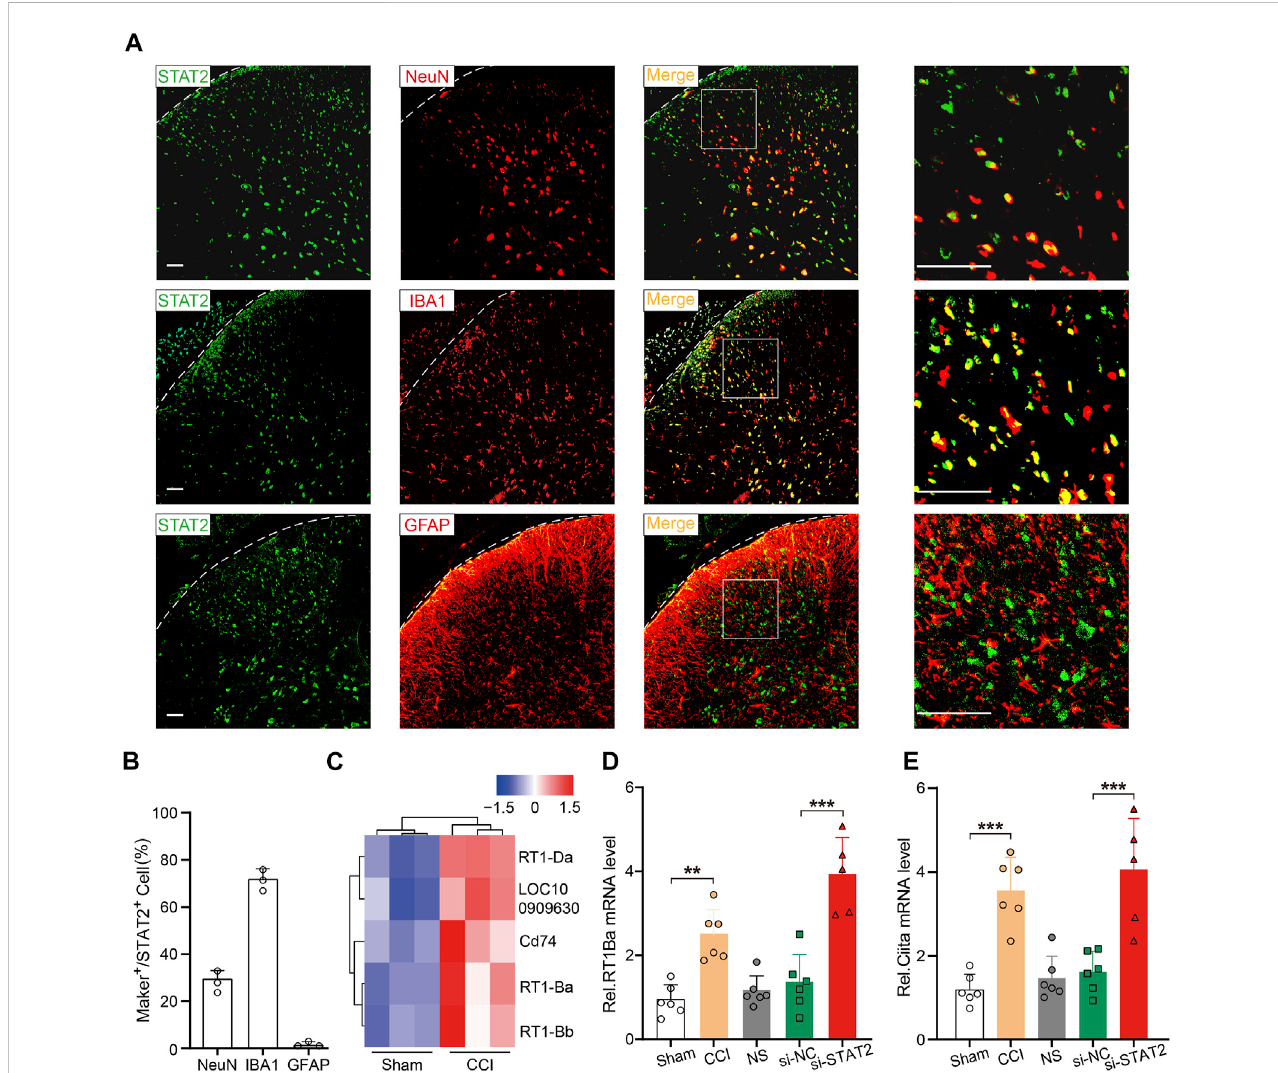
FIGURE 5 DownregulationofSTAT2 increased expression ofmicroglial activation markers. (A) Representative images showingimmunoreactivity for STAT2 (green) double labeled with NeuN-labeled neurons (red), IBA1-labeled microglia (red) or GFAP-labeled astrocytes (red) (scale bar = 50 µm). (B) The percentage of marker-positive (NeuN, IBA1, and GFAP) (green) cells relative to STAT2-positive (red) cells ( n = 3). (C) An RNA sequencing analysis heat map shows that major histocompatibility complex class II-associated genes were signi fi cantly upregulated in the SDH of chronic constriction injury (CCI) rats compared with those in the sham group. (D,E) Expression of RT1-Ba and Ciita mRNA was increased after CCI surgery and si-STAT2 injection ( n = 6/5 rats/group, ** p < .01, one-way ANOVA followed by Bonferroni ’ s multiple comparisons